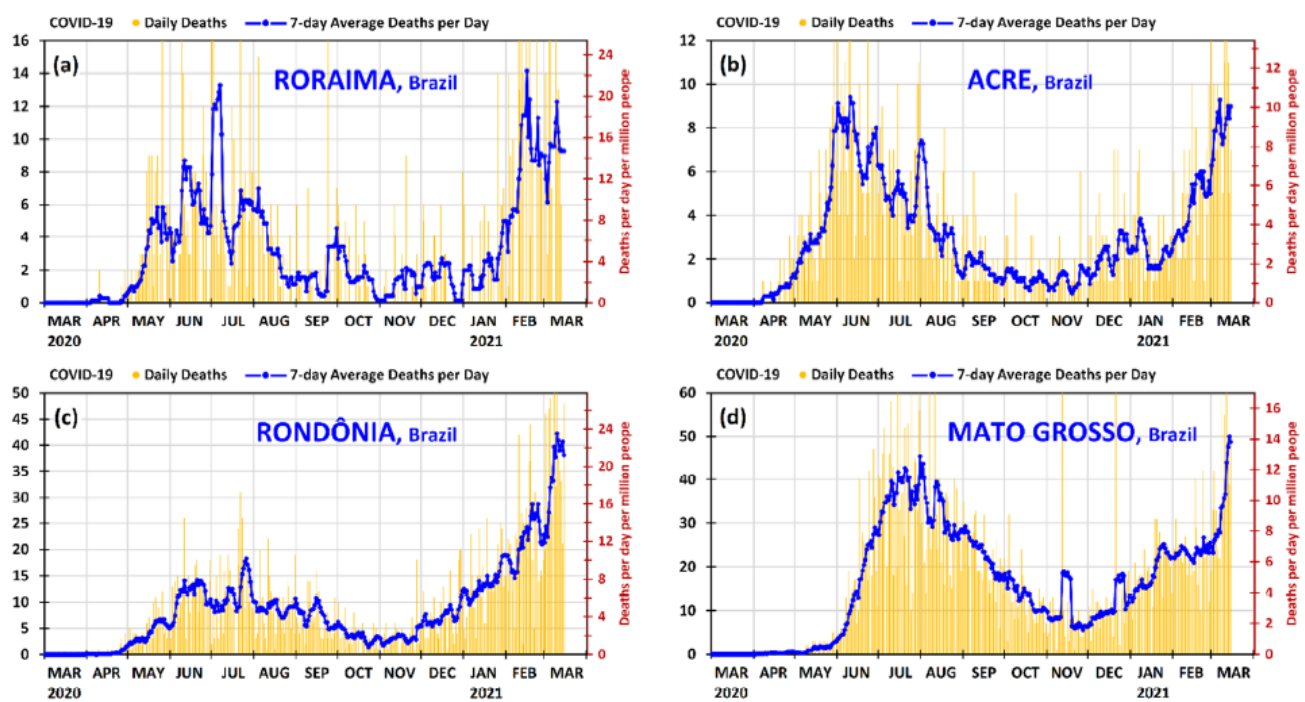
Figure 4. Daily deaths and 7-day average deaths per day of COVID-19 in the states of ( a ) Roraima, ( b ) Acre, ( c ) Rond ô nia and ( d ) Mato Grosso in Brazil from 1 March 2020 to 15 March 2021. The deaths per day per million people can be found using the secondary vertical axis on the